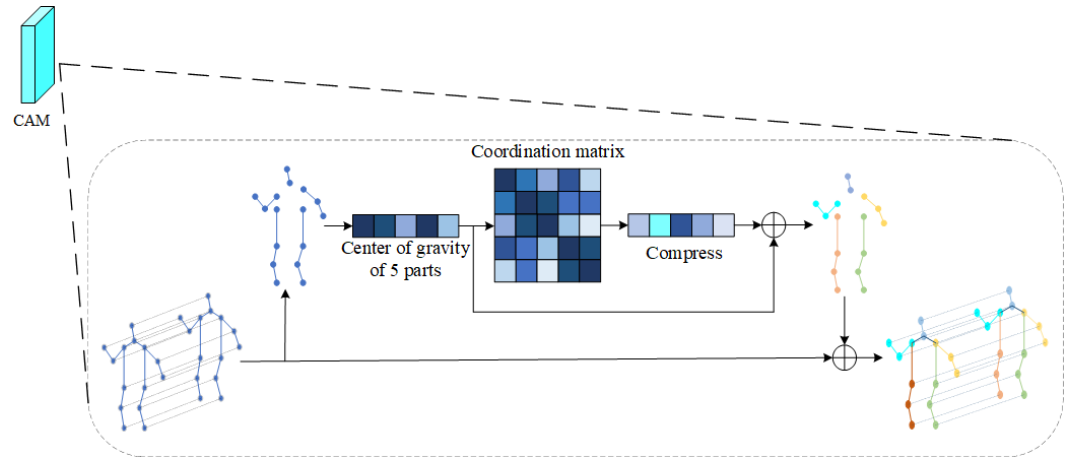
Figure 5. Coordination attention